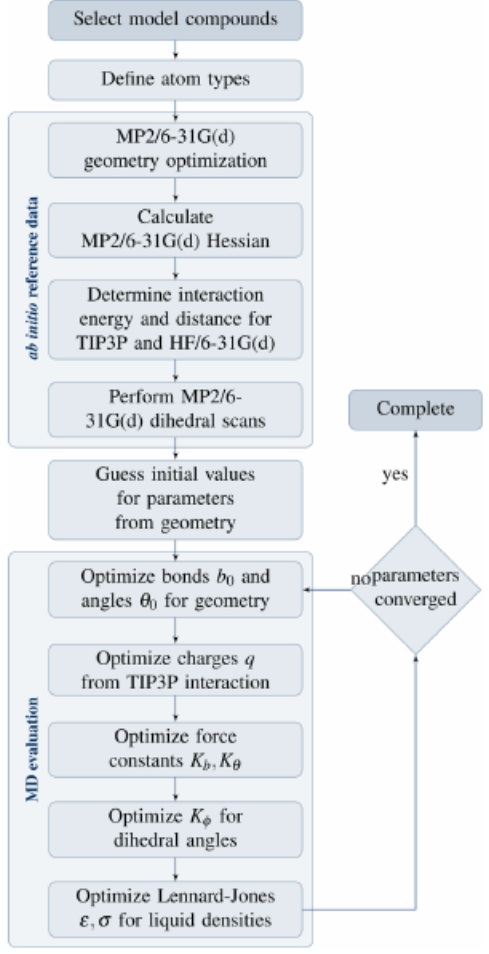
Figure 1. Parametrization scheme for the CHARMM force field as applied in this